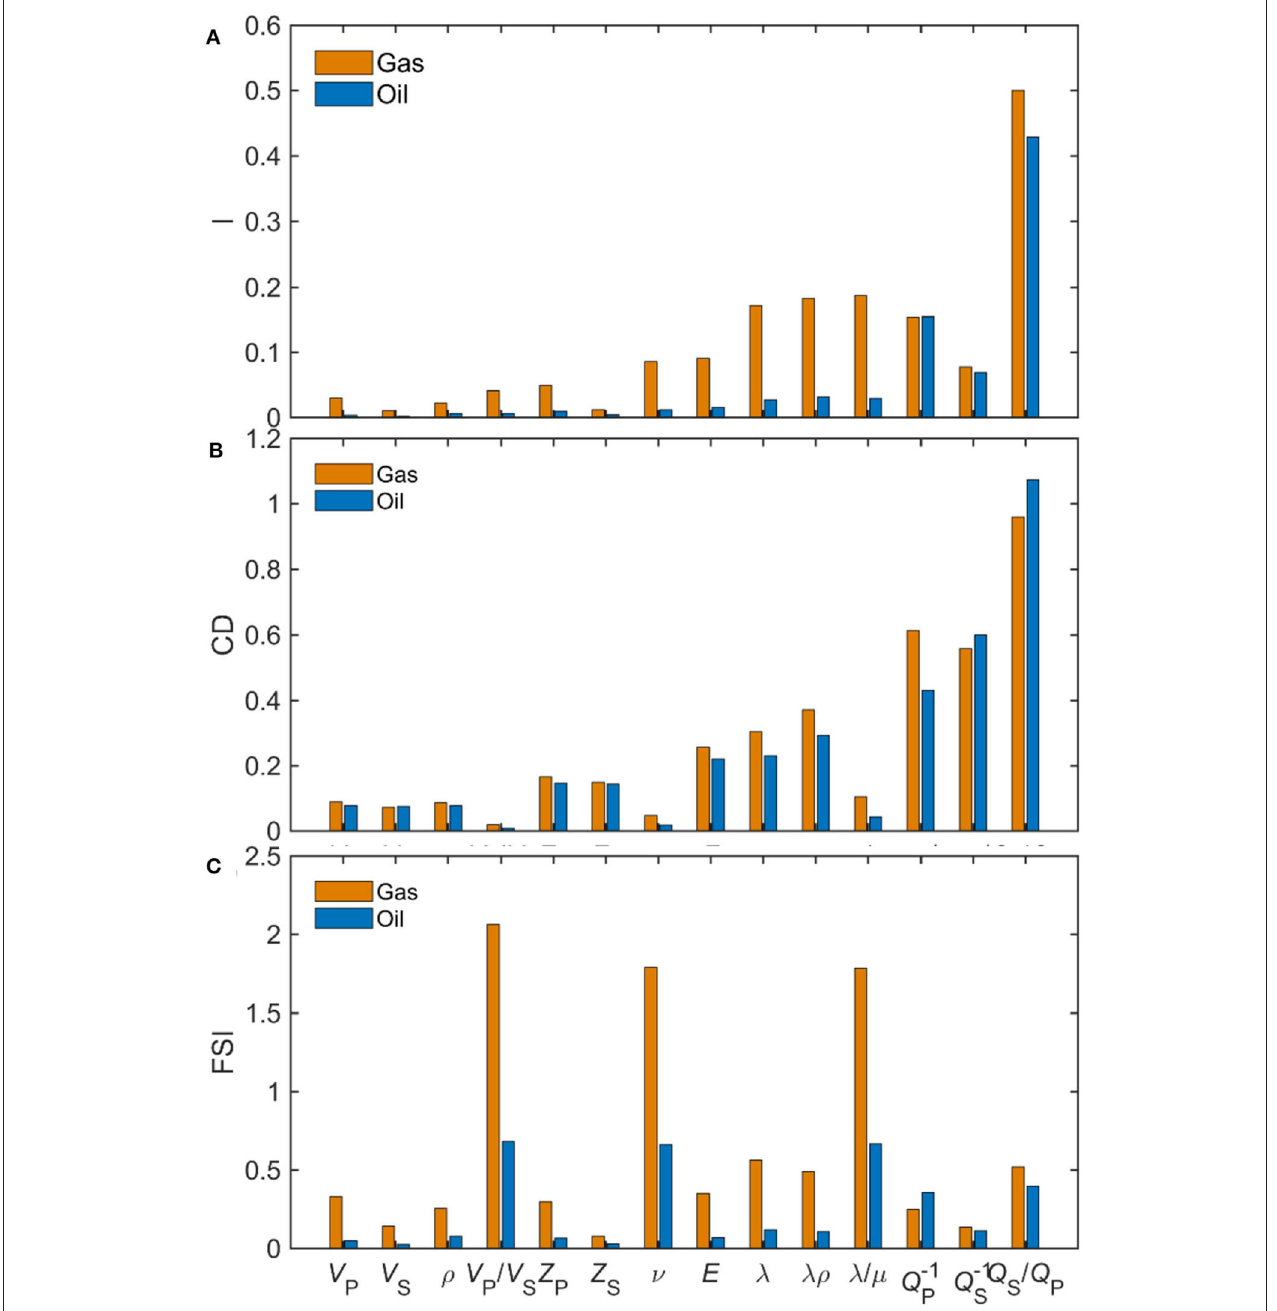
FIGURE 1 | (A) I, (B) CD, and (C) FSI for siltstones at full saturation. The brown and blue rectangles denote the values of fluid sensitivity to distinguish gas from water and oil from water,